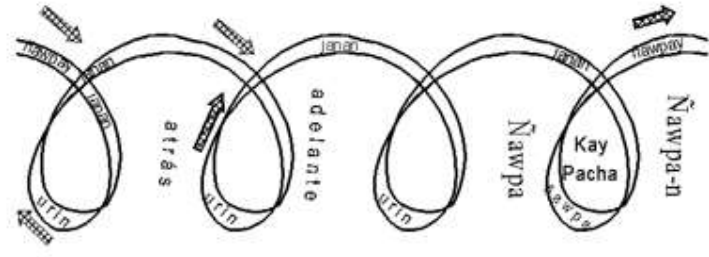
Figure 4: Pacha (space/time) observed from the front. Source: Manga E (2014).